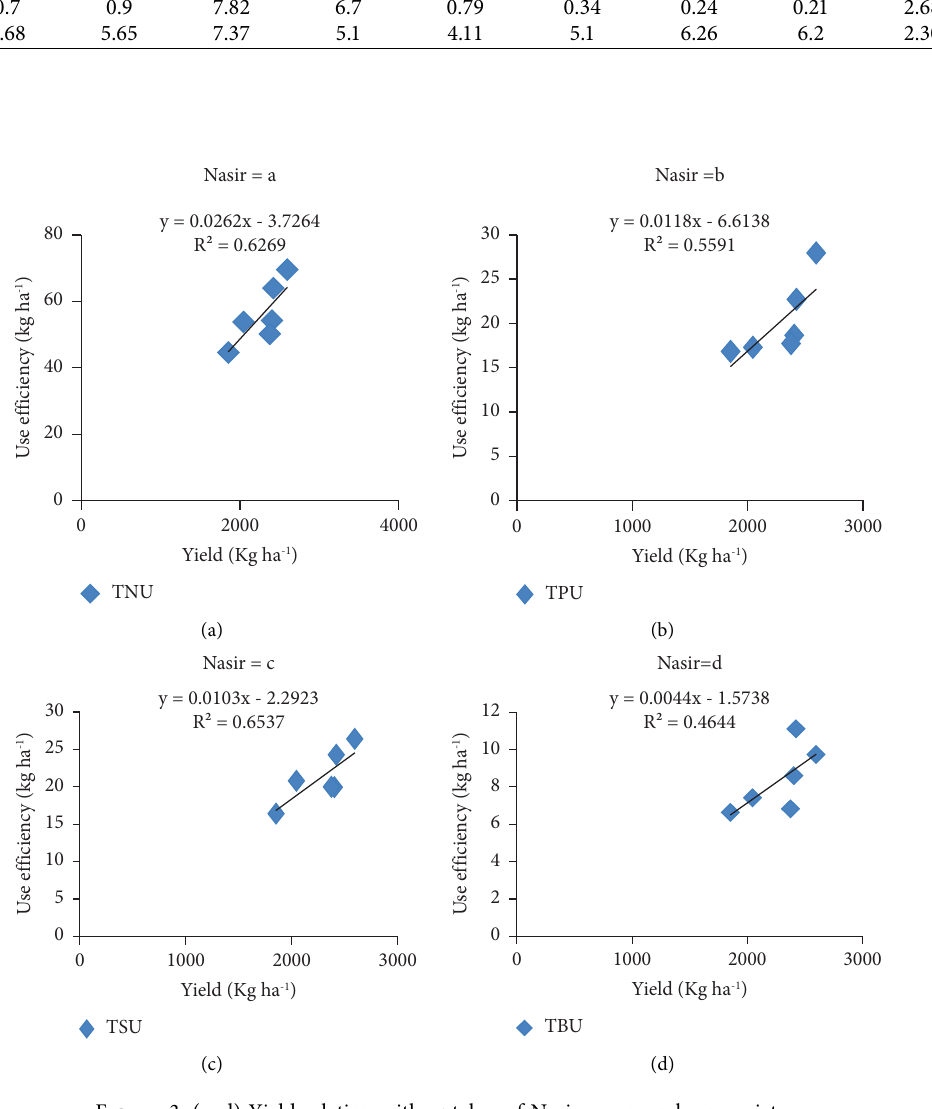
Figure 3: (a–d) Yield relation with uptakes of Nasir common bean